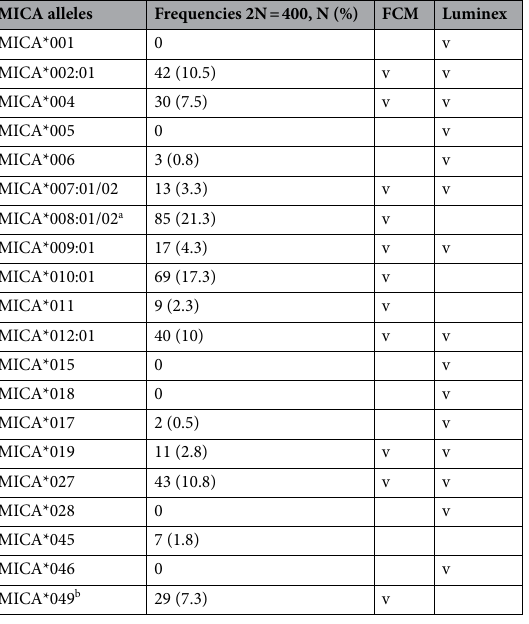
Table 1. MICA allele frequencies in Koreans and MICA alleles included in cell lines expressing single MICA allele for FCM and Luminex method. *Korean frequencies of MICA alleles have been reported in previous study 33 . *Each pairs of the marks, a (MICA*008:01 and *027) and b (MICA*009:01 and *049) have the same amino acid sequences of extracellular domain.